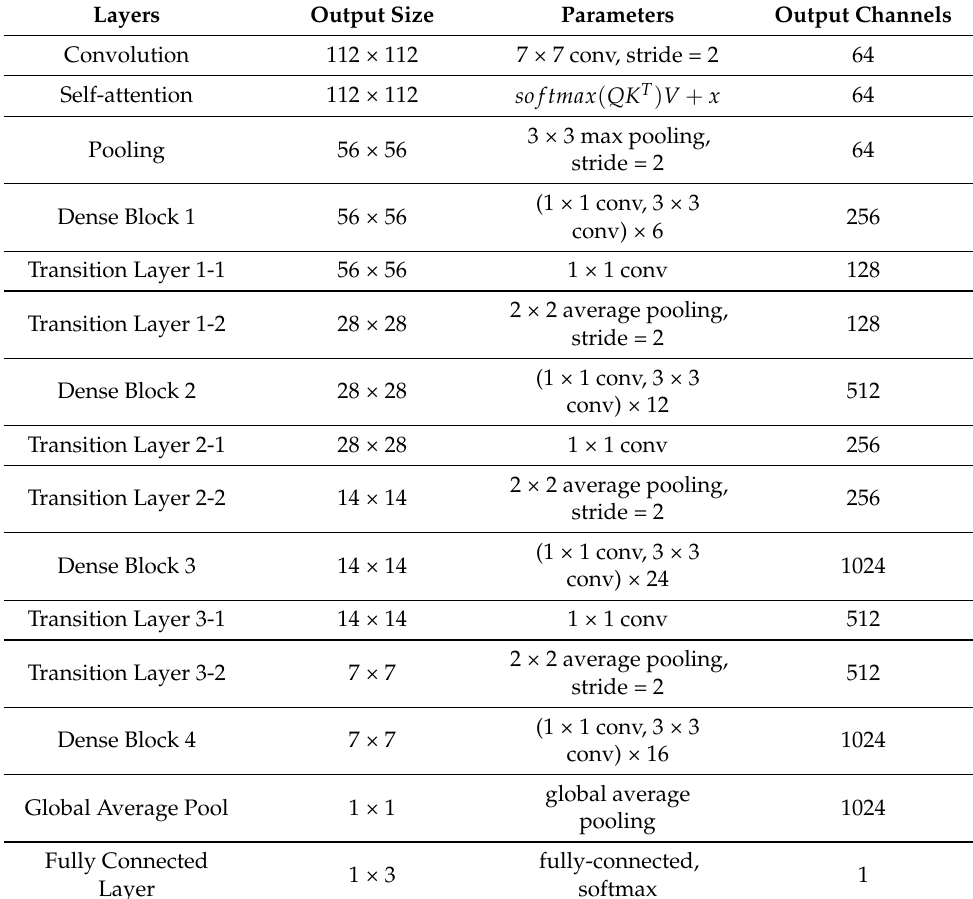
Table 4. The growth rate of the network is c = 32, and all “conv” in the table refers to executing BN-ReLU-Conv in